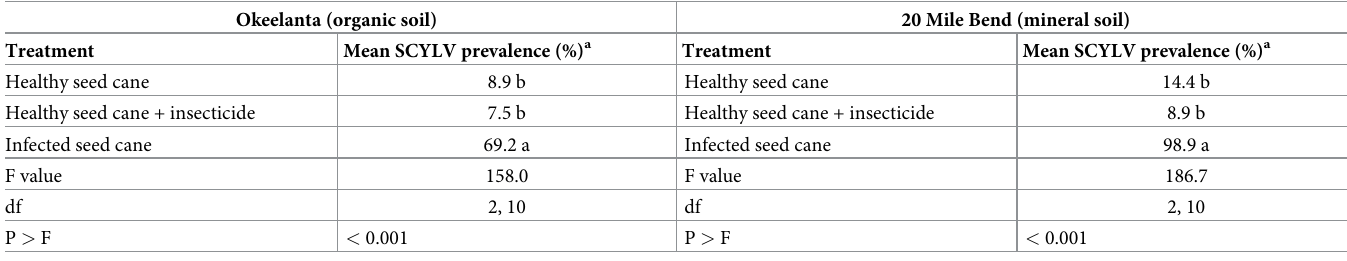
Table 2. Analysis of sugarcane yellow leaf virus (SCYLV) prevalence in sugarcane plots planted with healthy and infected CP96-1252 seed cane and grown from December 2016 to May 2019 at Okeelanta and from December 2016 to November 2018 at 20 Mile Bend.